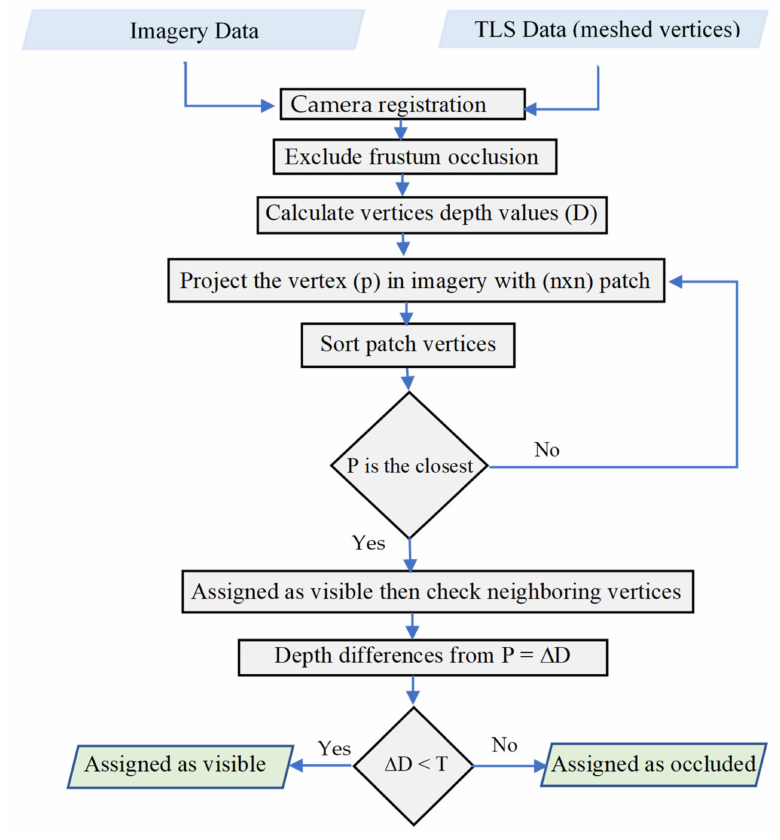
Figure 7. The flowchart of the visibility